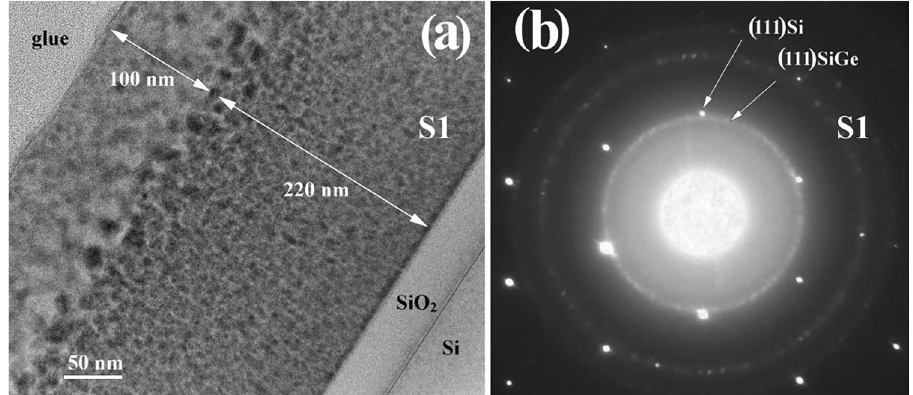
Figure 2. Morphology of S1 film with RTA at 800 °C, 15 min: ( a ) low magnification XTEM image, ( b ) SAED pattern of the film and Si substrate, showing the (111) Si spots and (111) ring spots of the SiGe NCs. Also, one can observe a strong amorphous component coming from the amorphous SiO 2 matrix and the SiO 2 buffer layer.